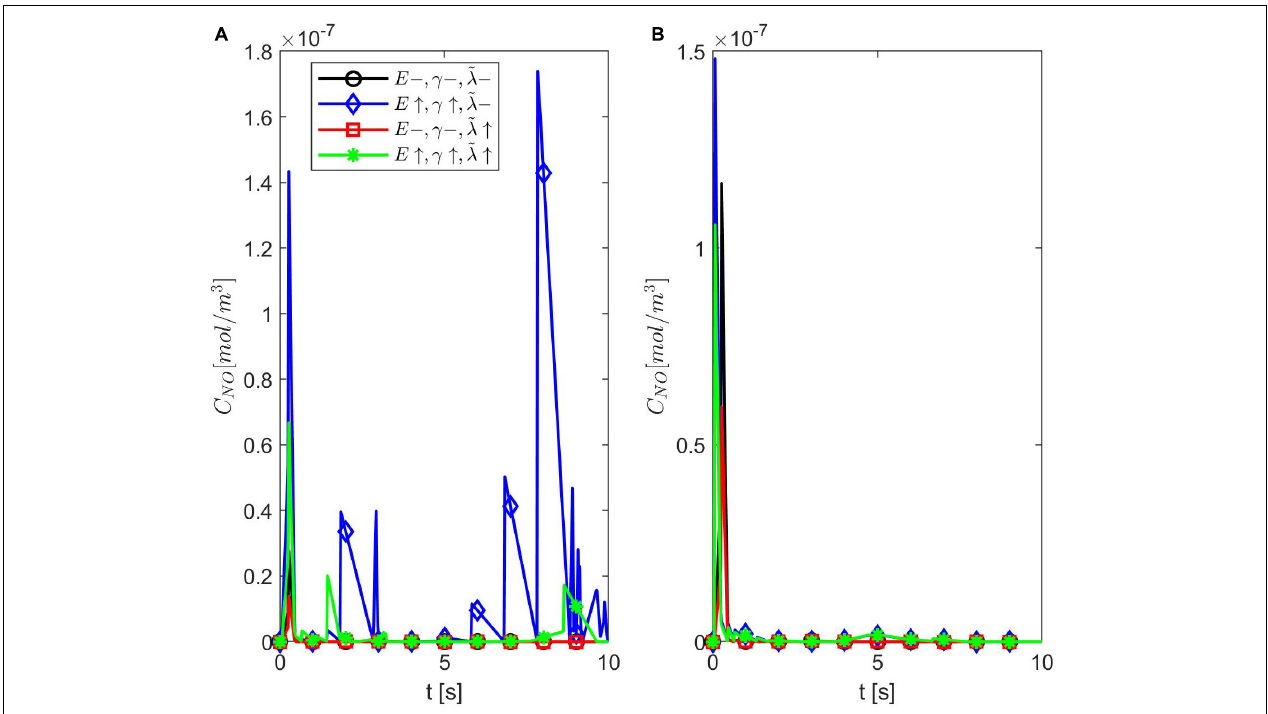
FIGURE 10 | Temporal profiles of C NO at r = a + h , the outer boundary of the endothelium, for ε = 0 . 75 , (A) p = 0 . 75 ( q = 0 . 25 ) , and (B) p = 0 . 25 ( q = 0 . 75 ) ( A,B have the same legend shown in A ). Here E = 6 × 10 3 N / m , γ = 0 . 75 , ˜ λ = 6 . 5325 × 10 3 s − 1 (black circle symbol), E = 6 × 10 4 N / m , γ = 1 . 25 , ˜ λ = 6 . 5325 × 10 3 s − 1 (blue diamond symbol), E = 6 × 10 3 N / m , γ = 0 . 75 , ˜ λ = 13 . 065 × 10 3 s − 1 (red square symbol), and E = 6 × 10 4 N / m , γ = 1 . 25 , ˜ λ = 13 . 0655 × 10 3 s − 1 (green star